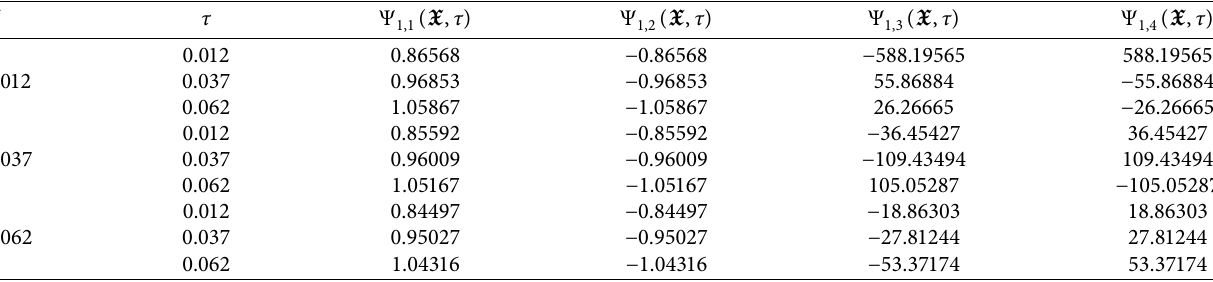
Table 2: The imaginary part of exact solutions of CTFMNLSE (1) obtained by the TEM with several point sources through arbitrary.